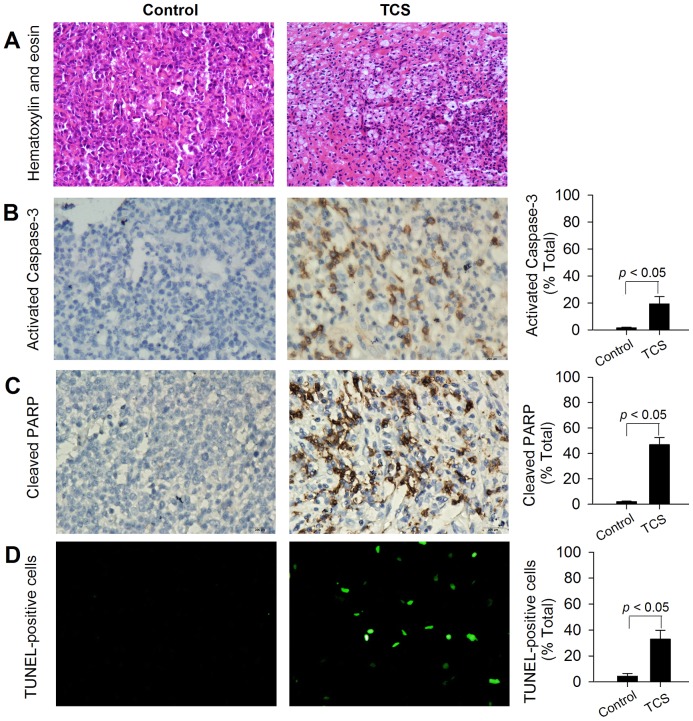
TCS-induced necrosis and apoptosis in MDA-MB-231 xenograft.MDA-MB-231-bearing nude mice were treated with a TCS dose of 5.0 mg/kg every other day by i.p. injection for a total of 7 injections. On day 16 post-cell injection, tumors were excised carefully, and immunohistochemistry studies were performed as detailed in Materials and methods. Positive cells in each study were scored semi-quantitatively. A. HE staining. B. Tumor slides were examined for apoptosis by activated caspase-3. Representative images from both groups are shown, and positive cells were stained brown. C. Tumor slides were examined for apoptosis by cleaved PARP. Representative images from both groups are shown, and positive cells were stained dark brown. D. TUNEL assay was used for detecting DNA fragmentation. Representative images from both groups are shown with TUNEL-positive cells colored green. Microscopic magnification 200×.